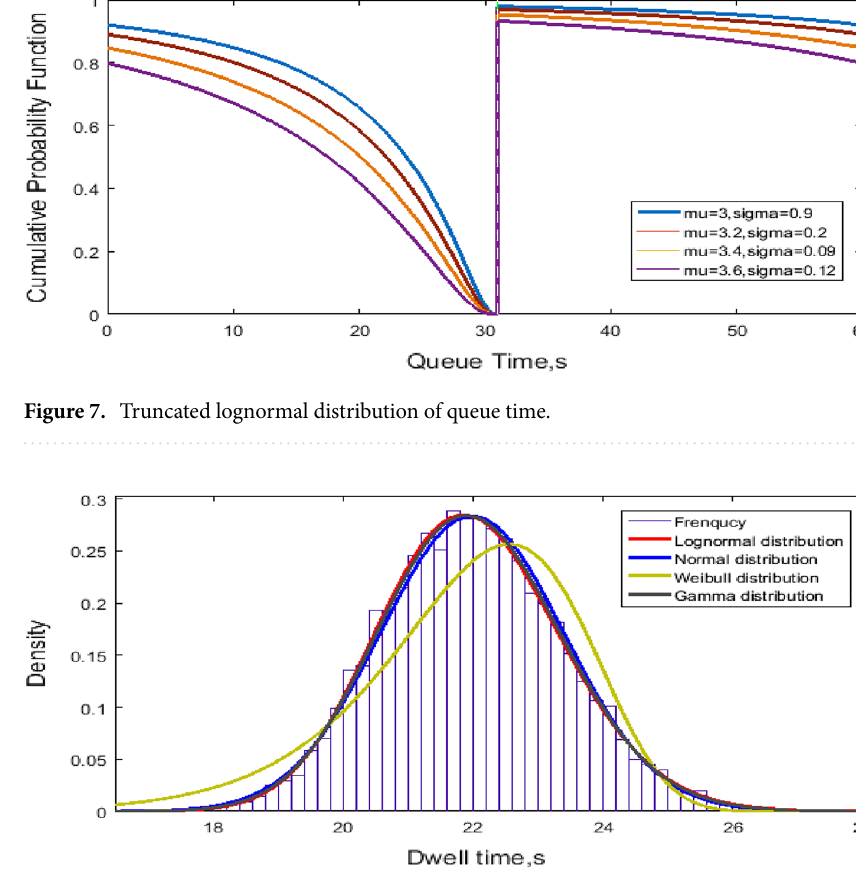
Figure 8. Dwell time at the C-th berth.